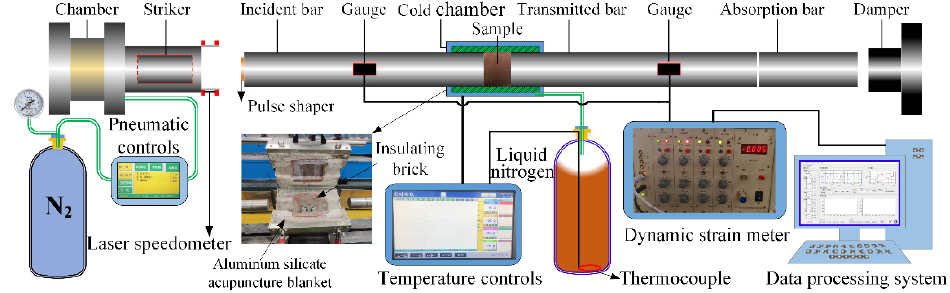
Figure 4. The LT-SHPB system.